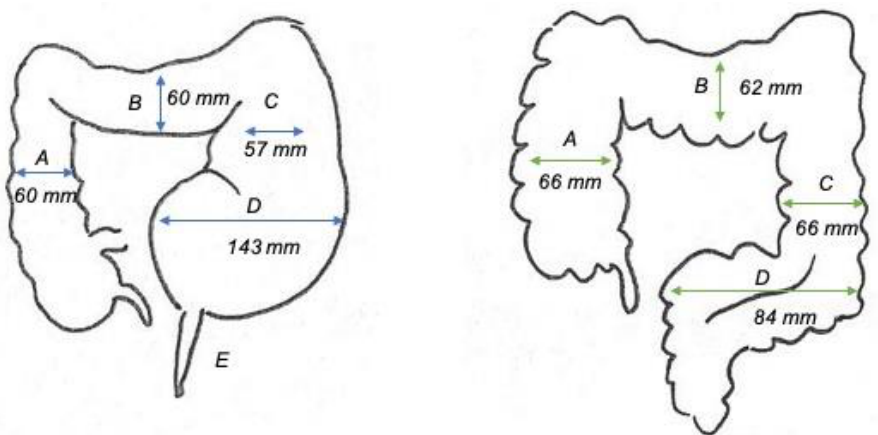
Figure 3. Schematic representation of the colonic frame in Hirschsprung’s disease (HD) patients and non-HD patients with colonic volvulus (E = narrow aganglionic colon, D = sigmoid, C = descending colon, B = transverse colon, A = ascending colon).